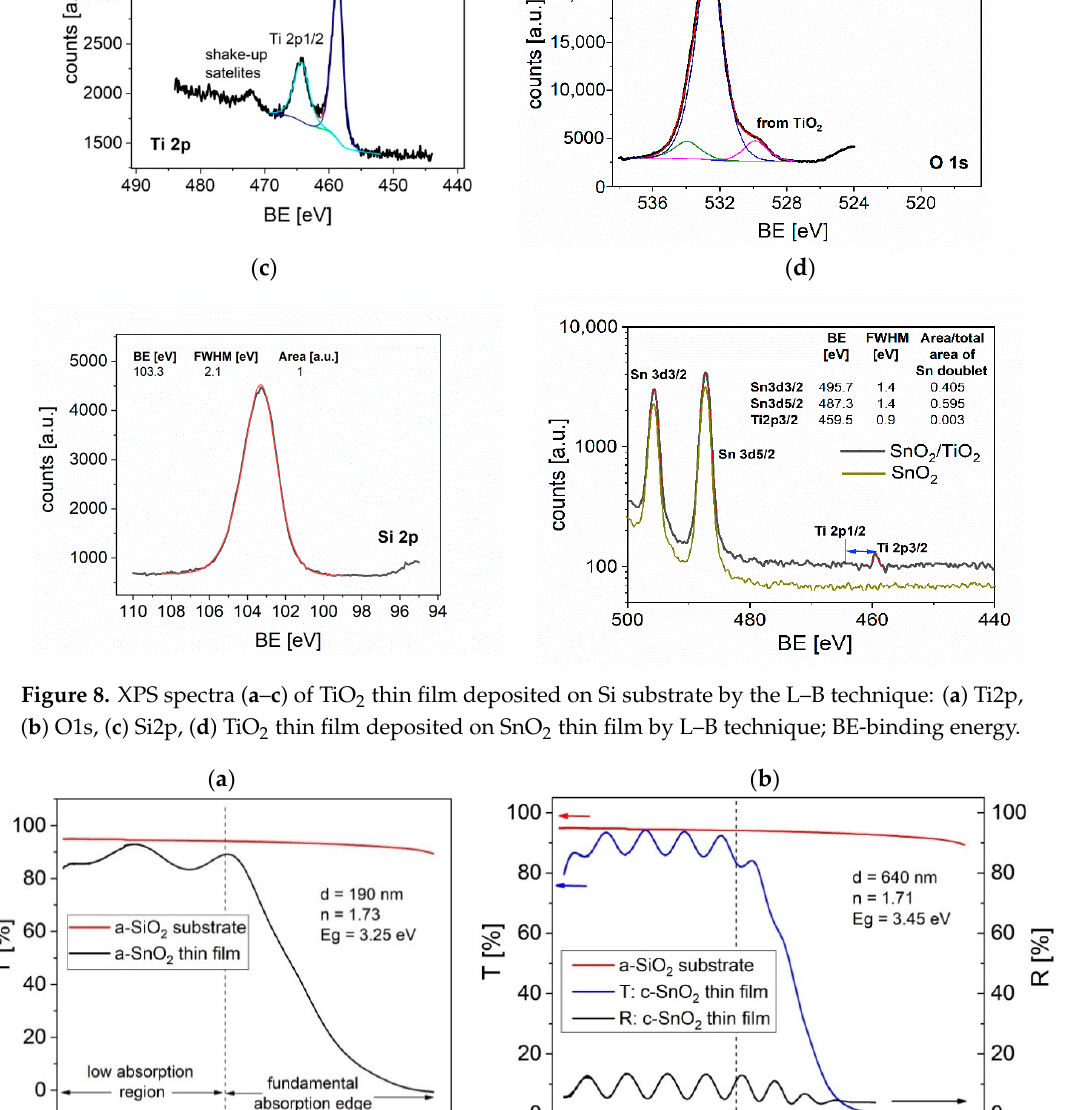
Figure 8. XPS spectra ( a – c ) of TiO 2 thin film deposited on Si substrate by the L–B technique: ( a ) Ti2p, ( b ) O1s, ( c ) Si2p, ( d ) TiO 2 thin film deposited on SnO 2 thin film by L–B technique; BE-binding energy.